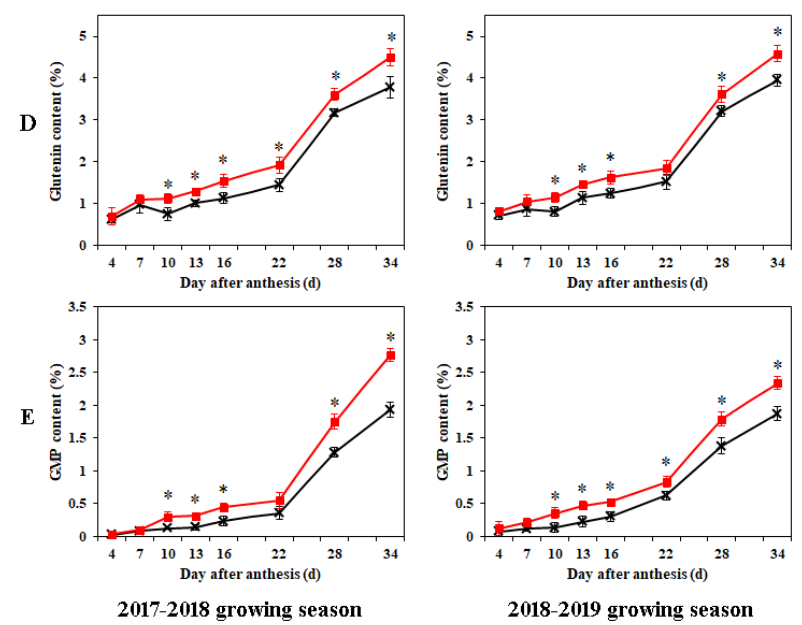
Figure 2. Dynamic accumulation of total protein and its components in grains from HMW-D1a and HMW-D1p over two growing seasons, 2017–2018 (left) and 2018–2019 (right). ( A ) total protein; ( B ), albumin and globulin; ( C ) gliadin; ( D ) glutenin; ( E ) GMP. Red and black lines represent the HMW-D1p and HMW-D1a, respectively. * indicates significant di ff erence at same developing stage of the two materials ( p <